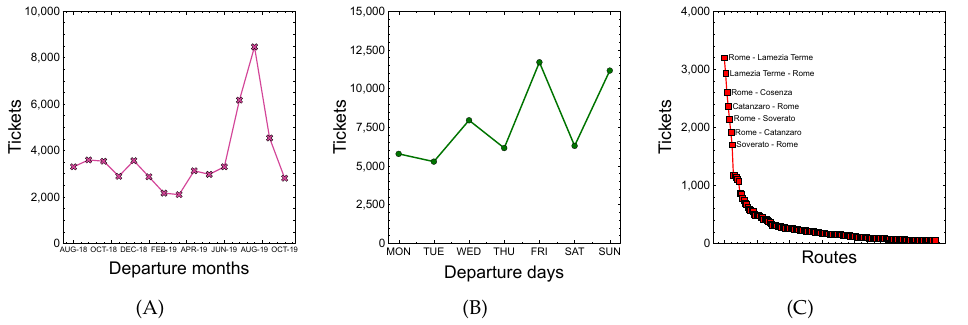
Figure 3. No. of purchased tickets considering ( A ) departure month , ( B ) departure day of the week , and ( C ) route attributes.